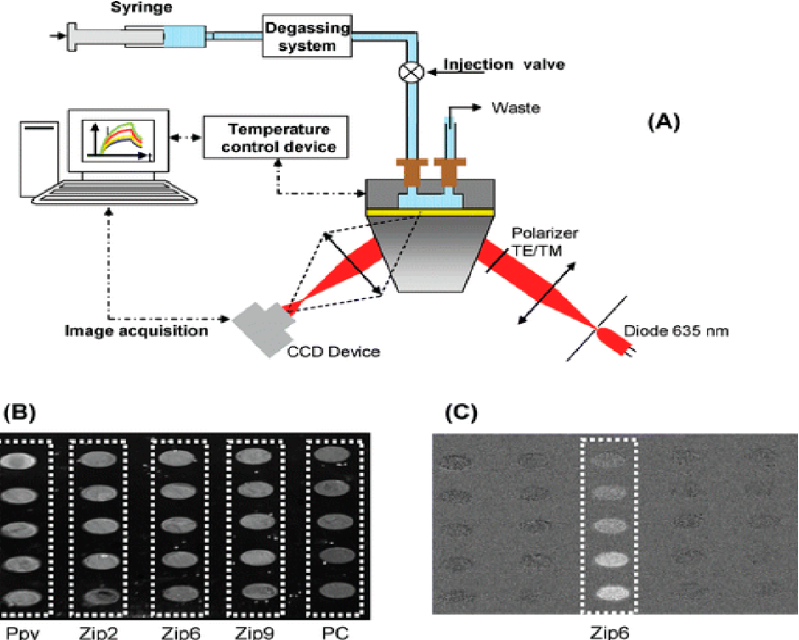
Figure 3. ( A ) Experimental set-up of a SPR imaging (SPRi) sensor. The recorded data are represented as intensity variation of the reflected light at a fixed angle for each region of interest (ROI) selected; ( B ) Image of the DNA chip as seen from the charge-coupled device (CCD); ( C ) Differential image registered during the injection of a single-strand ssDNA target. The image was obtained by subtracting the image registered before injecting the target from image of the chip during hybridization (reproduced from [39] with permission of RSC Publishing).